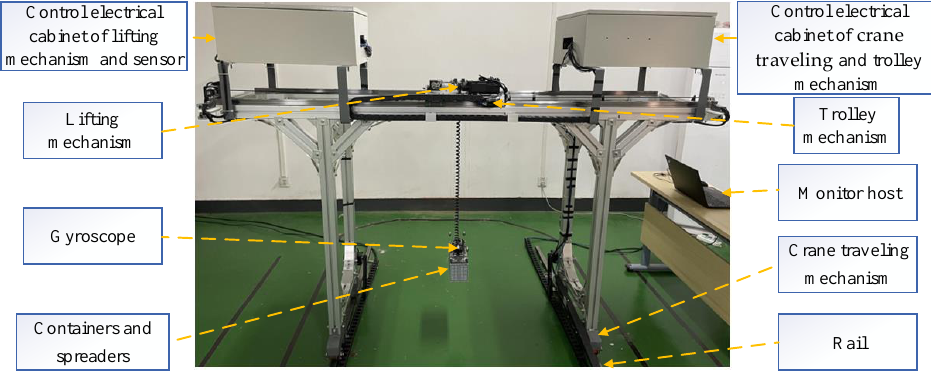
Figure 2. Photo of the miniature RMGC physical platform.